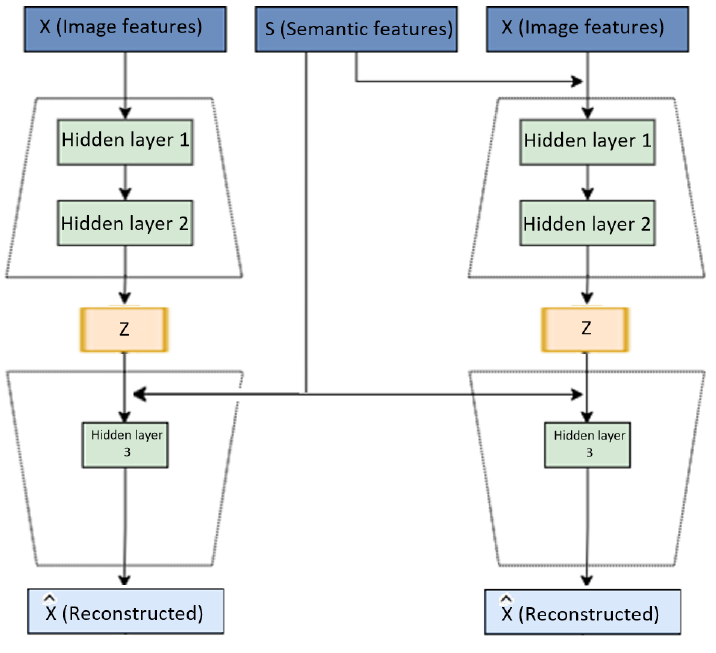
Figure 1. The proposed approach consists of two autoencoders. The first autoencoder is provided by the concatenated vectors of the visual and semantic spaces. The second autoencoder is provided by the visual features vectors only. Both autoencoders have a dense layer, followed by a dropout and a second dense layer. This is followed by another layer, which generates the values z. Activation functions are ReLU, and the activation functions for the last layer for both the encoder and the decoder are